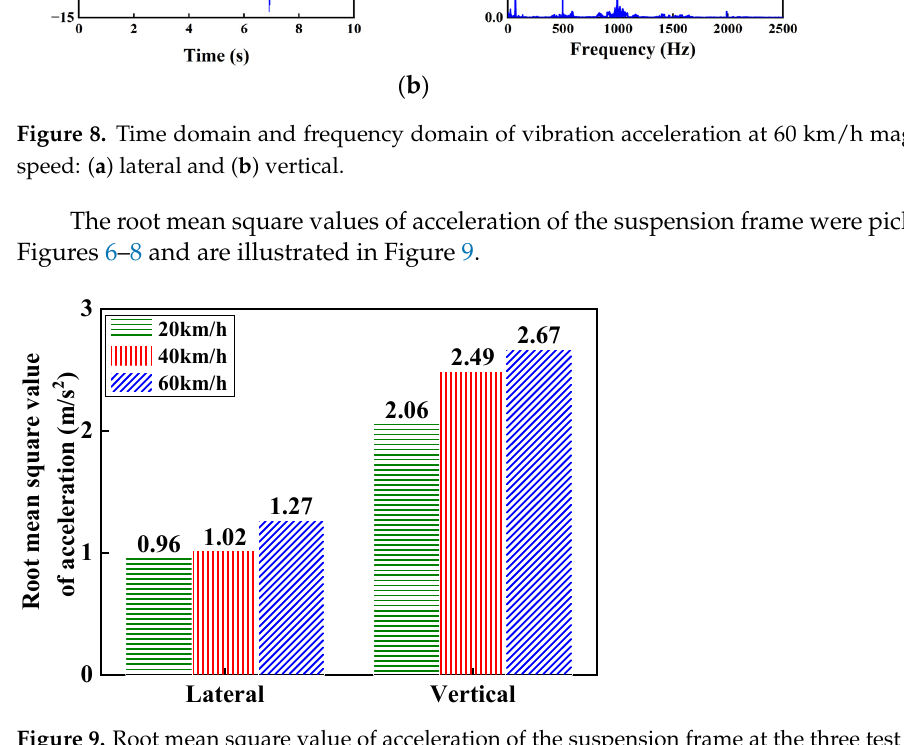
Figure 9. Root mean square value of acceleration of the suspension frame at the three test speeds in the lateral and vertical direction.